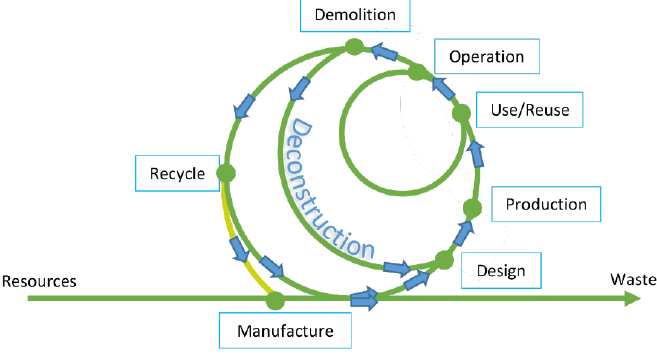
Figure 1 – Implementation of Circular Economy in